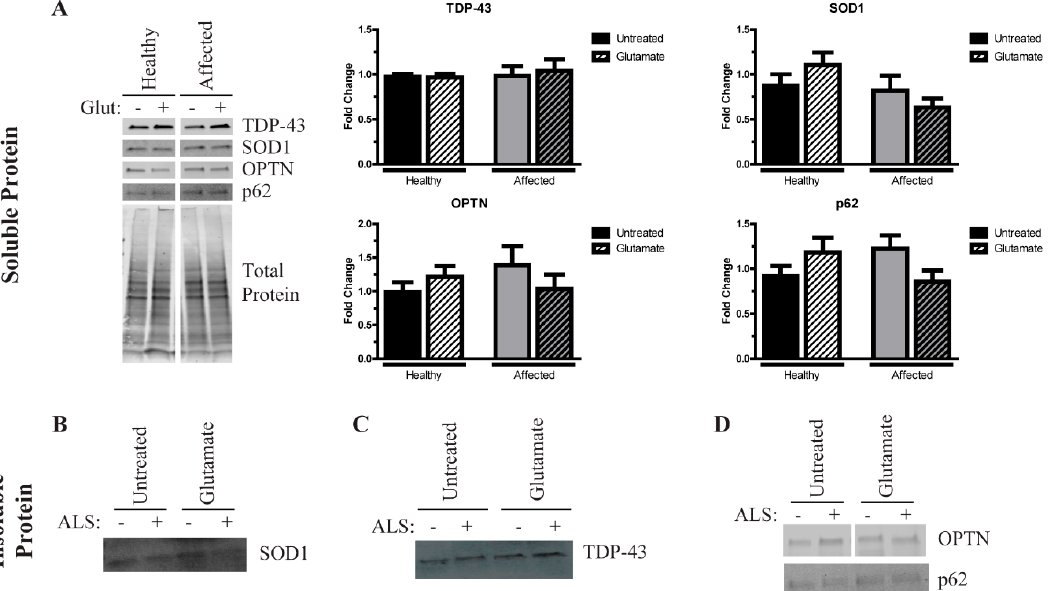
Figure 3. MNs from the discordant identical twins have similar levels of insoluble protein. ( A ) Western Blots of soluble protein samples show similar levels of SOD1, optineurin (OPTN), p62, or TDP-43 in the affected and unaffected twin MNs at baseline or after treatment with 100µM glutamate for 96 h. n = 4–7. ( B ) There is no appreciable difference in the levels of insoluble SOD1 in the affected MNs compared to unaffected MNs at baseline. Treatment with 100 µM glutamate has a variable effect on aggregation in both cultures. n = 4–7. ( C ) Insoluble TDP-43 is similar in the affected and unaffected MNs that does not consistently increase or decrease after treatment with 100 µM glutamate. n = 4–7. ( D ) The levels of insoluble OPTN and p62 in the affected MNs are not significantly different compared to the unaffected MNs. Glutamate treatment has no consistent effect on insolubility. n = 4–7.